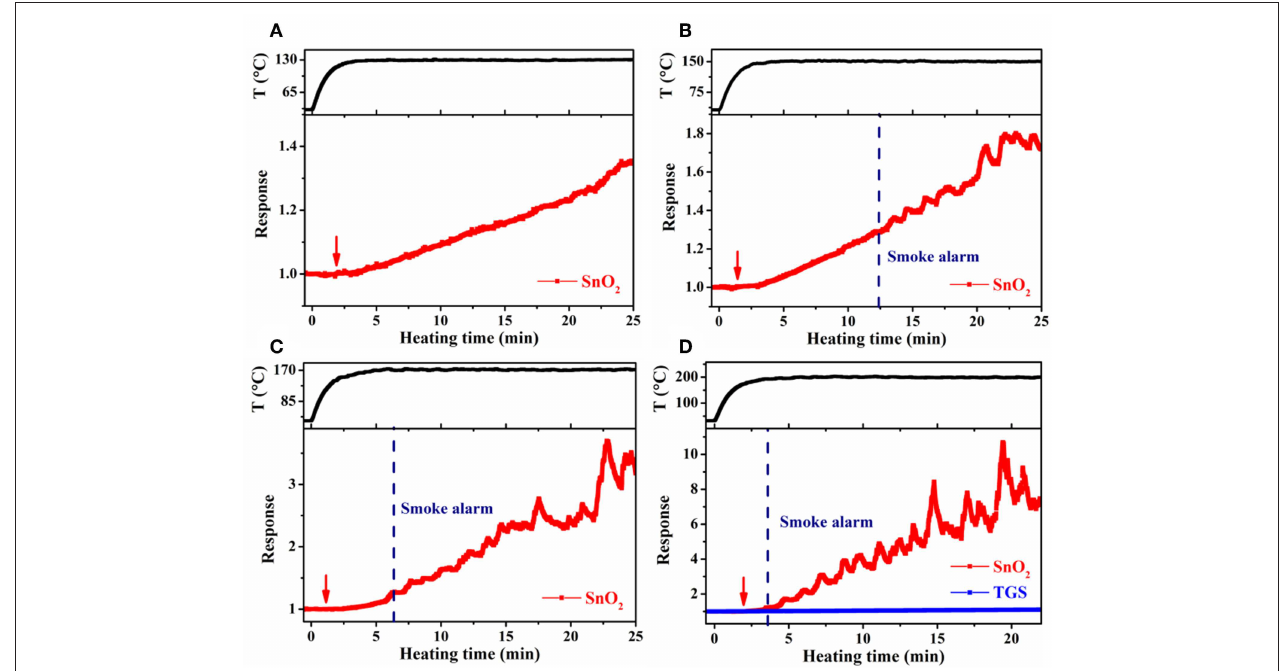
FIGURE 7 | Response of SnO 2 nanofiber sensor as a function of heating time at a cable temperature of (A) 130 ◦ C, (B) 150 ◦ C, (C) 170 ◦ C, and (D) 200 ◦ C during large-scale simulation tests for cable 1. Arrow indicate onset of sensor response.